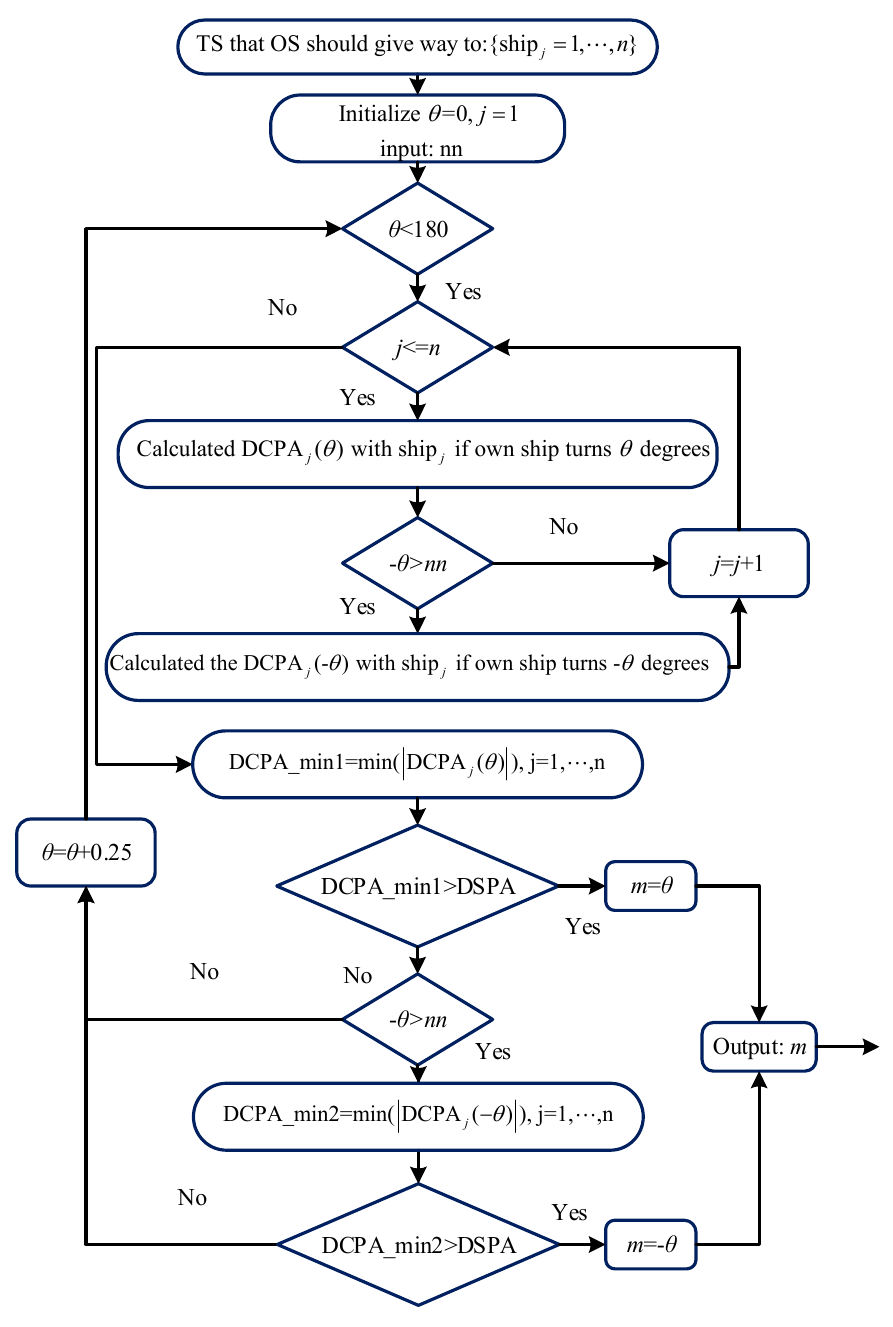
Figure 3. The evasive action of the give ‐ way vessel.